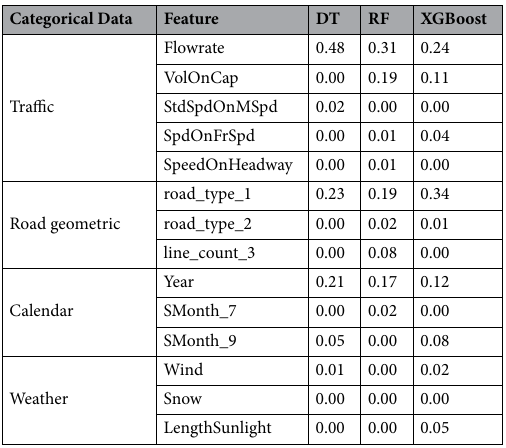
Table 9. Feature importance of variables in developed